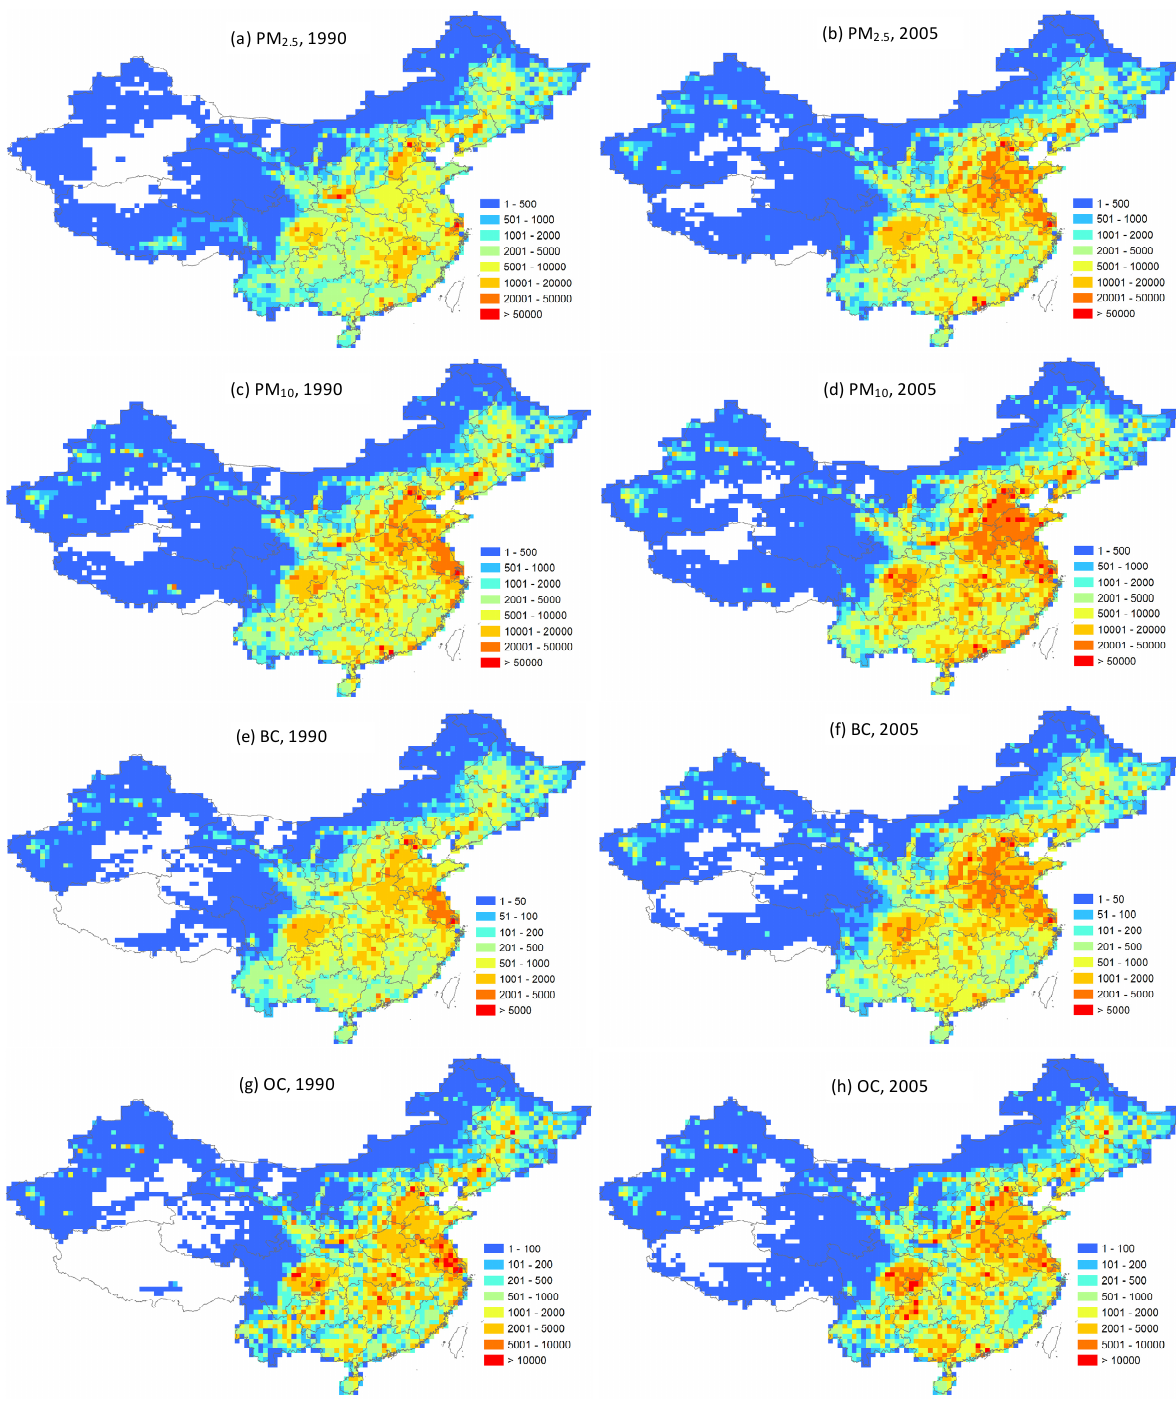
Fig. 11. Emissions of PM 2 . 5 , PM 10 , BC and OC in 1990 and 2005 by 30 0 × 30 0 grids. Unit: Mg/grid cell.